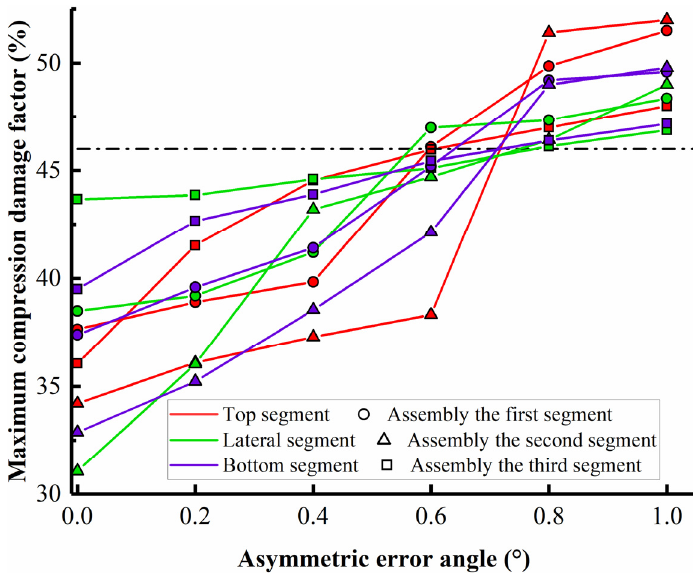
Figure 14. Maximum compression damage factor in the presence of inward deflection.